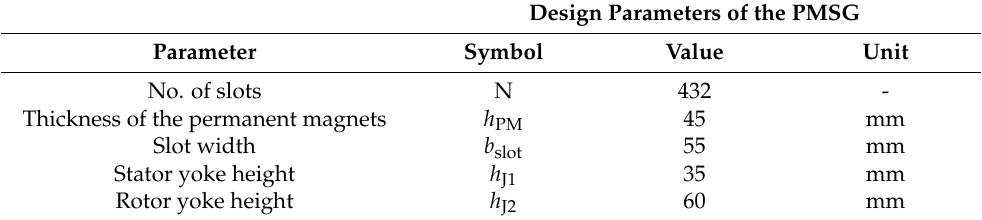
Table 3. Design parameters of the